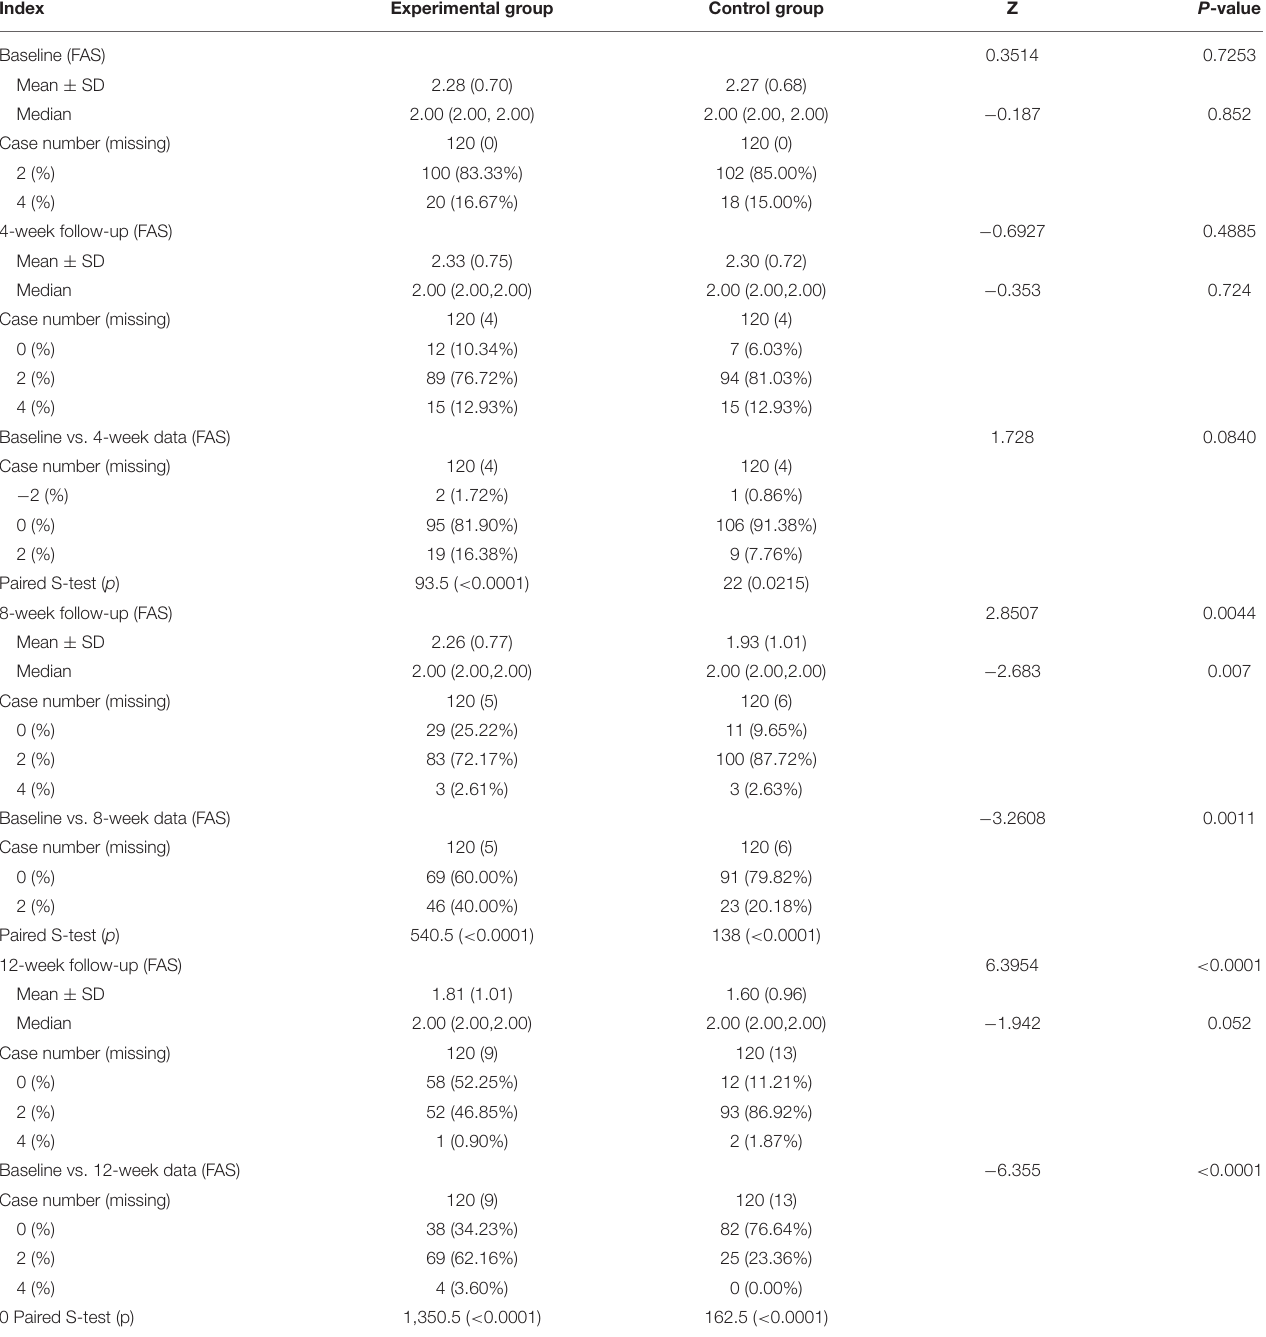
TABLE 9 | Comparison of number of angina attacks per week between the two groups